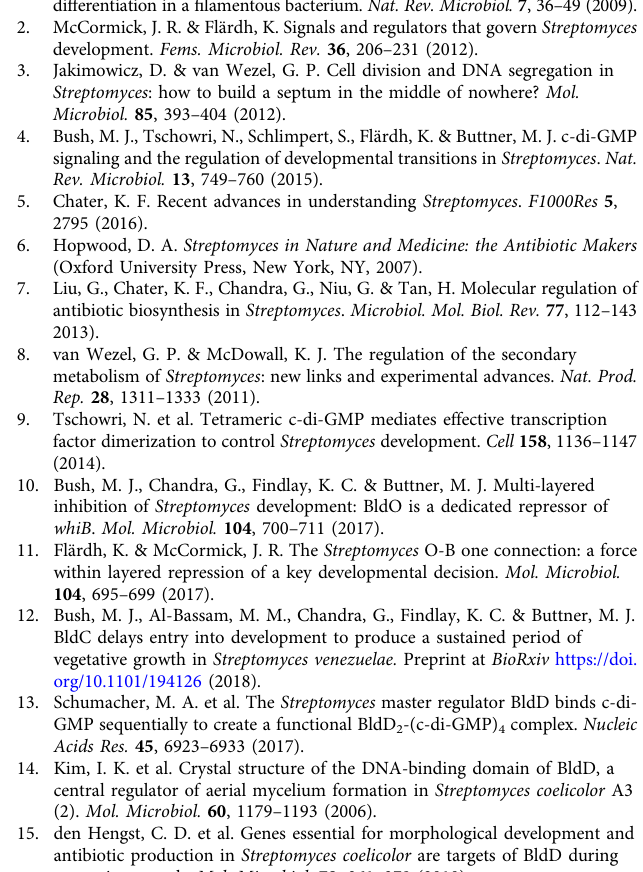
Fluorescence polarization-based DNA binding experiments . Fluorescence polarization (FP) experiments were performed using a PanVera Beacon 2000 FP system at 25°C. 5 ′ -Fluroesceinated oligonucleotides were used for DNA binding experiments with WT BldC and BldC mutants. For each FP experiment, WT BldC or BldC mutant protein were titrated into 0.995 mL of reaction buffer (25 mM Tris, pH 7.5, 150 mM NaCl) containing 1nM fl uoresceinated oligonucleotide. Fluor- esceinated oligonucleotides used in the experiments include the whiI opt (top strand: 5 ′ -F-TTCAATTCGGACAATTCGGACA-3 ′ where 5 ′ -F denotes the 5 ′ fl uorescein label), 36mer optimized site (top strand: 5 ′ -F-ATTCGGA- CAATTCGGACAATTCGGACAATTCGGACA-3 ′ ) and the smeA-ssfA promoter site (top strand: 5 ′ -F-TAATTCGGTCGAATTTCCCCCATTTGCACCTTT- TATCGTA-3 ′ ). The sequences of the three mutant whiI opt sites used